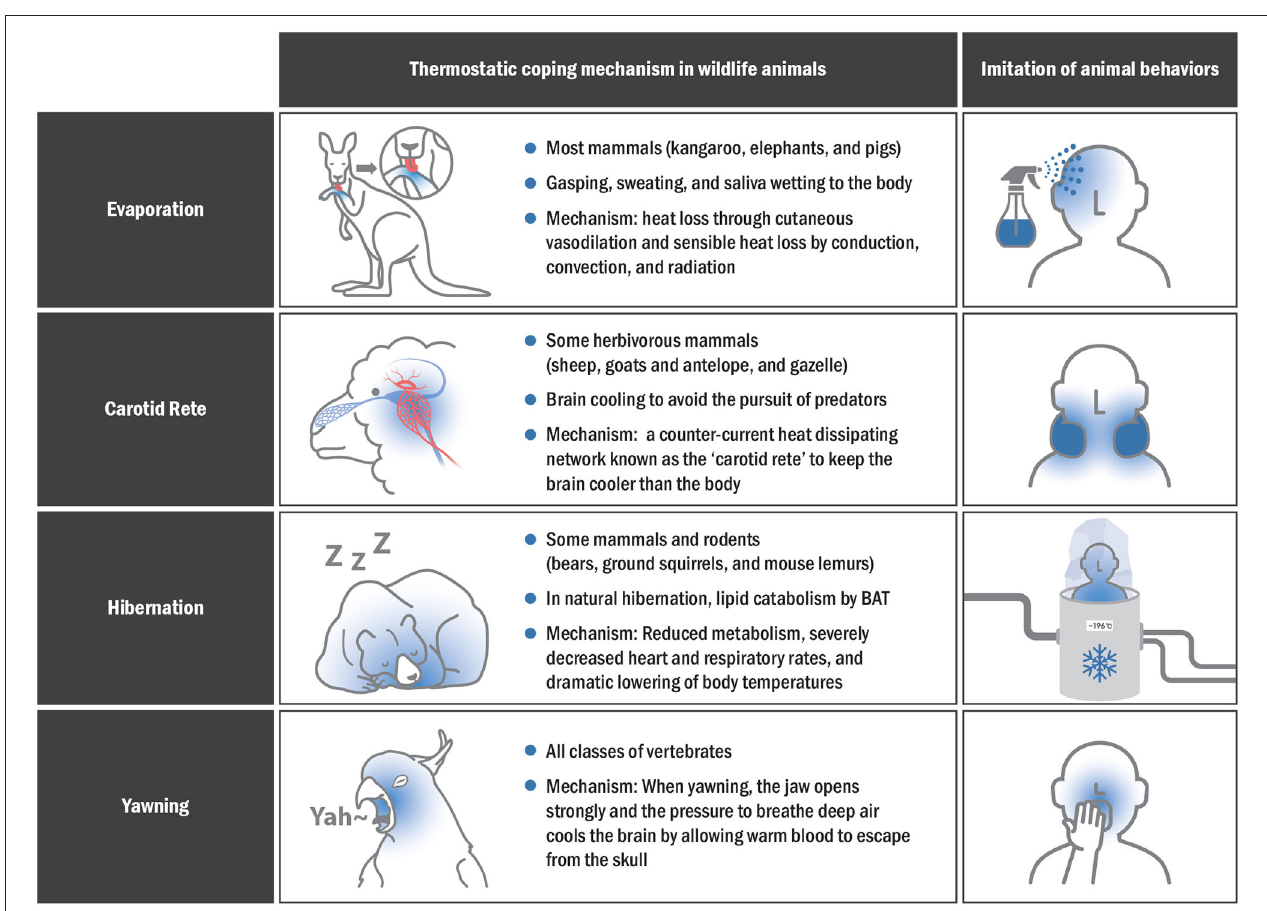
FIGURE 4 | Thermostatic mechanisms in animals and imitation of their behaviors for effective SBC application in